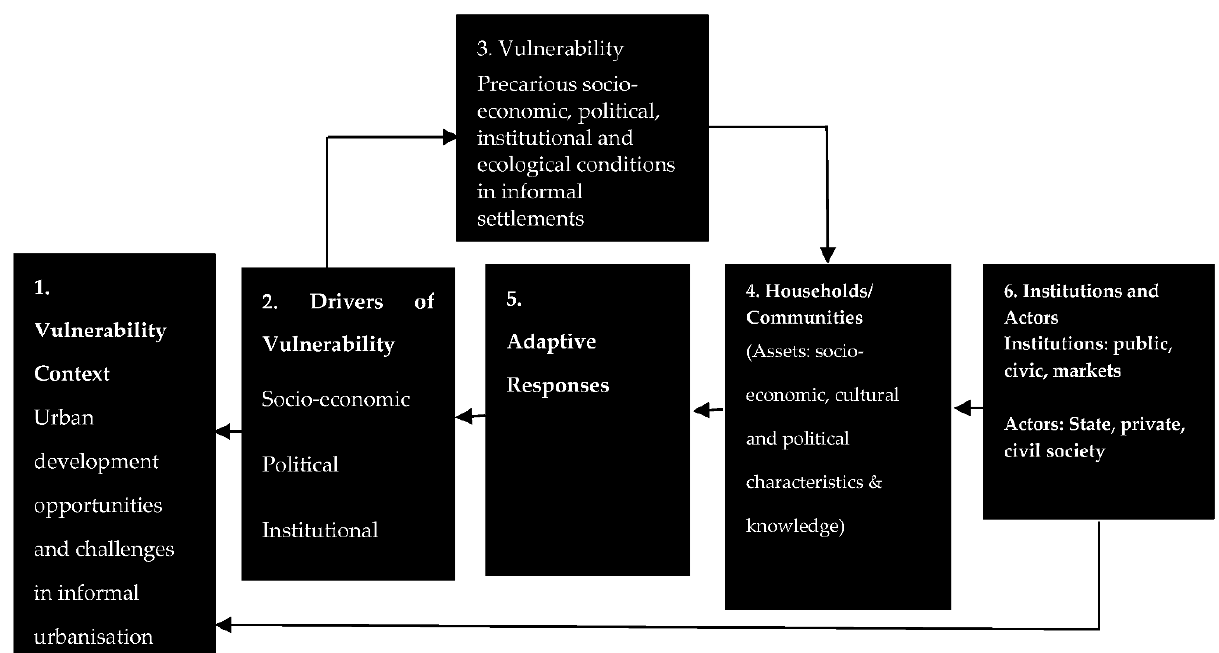
Figure 1. Theoretical Framework. Source: Authors’ adaptation of Roy et al. (2013, p. 159) (Reprinted/adapted by Permission of SAGE Publications. Copyright© 2013 by Roy et al. 2013 ) .